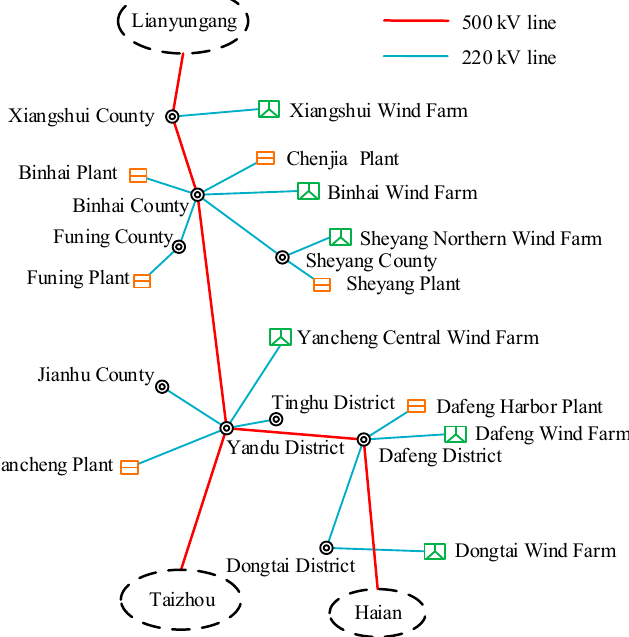
Figure 3. Topological structure of power system in Yancheng. Table 1. Parameters of high-energy load users.